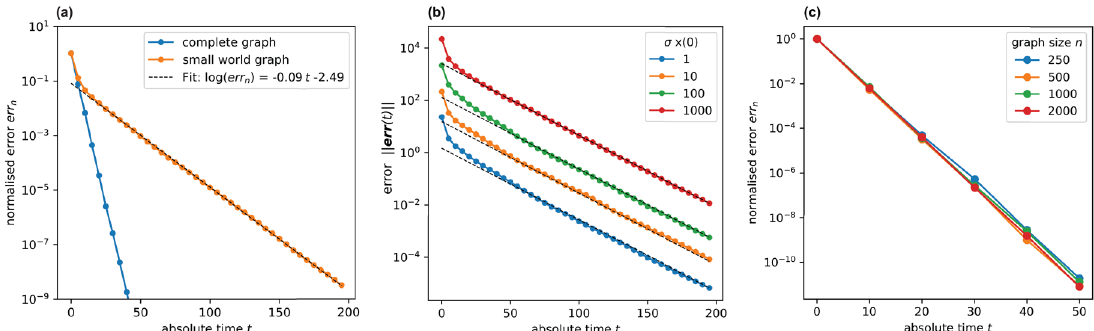
1000 and average degree deg 20 , after a faster transient phase, Figure 2. ( a ) In a SW graph with size n avg = = the logarithm of the normalised error decreases linearly but at a slower rate than the complete graph of the same size. The convergence rate can be estimated as the angular coefficient of the regression line of the normalised error with respect to time. ( b ) In graphs where nodes are assigned values from a Gaussian random distribution 0 and σ varying in [0, 1000], the angular coefficient of the regression line is constant, i.e. the with µ = convergence rate is independent of the initial values. ( c ) The convergence rate in complete graphs is independent of the graph size n